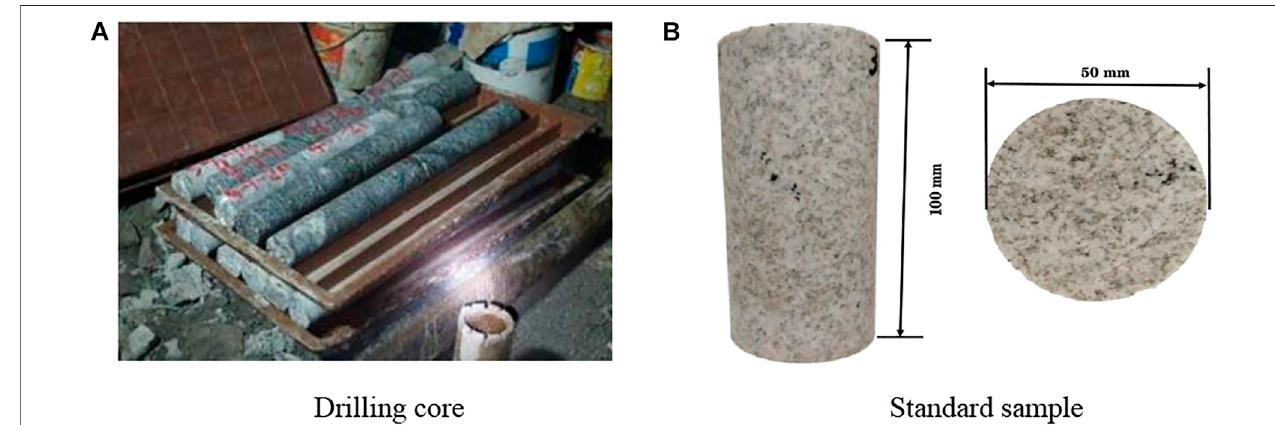
FIGURE 1 | Test sample source and shape: (A) Drilling core; (B) Standard sample.